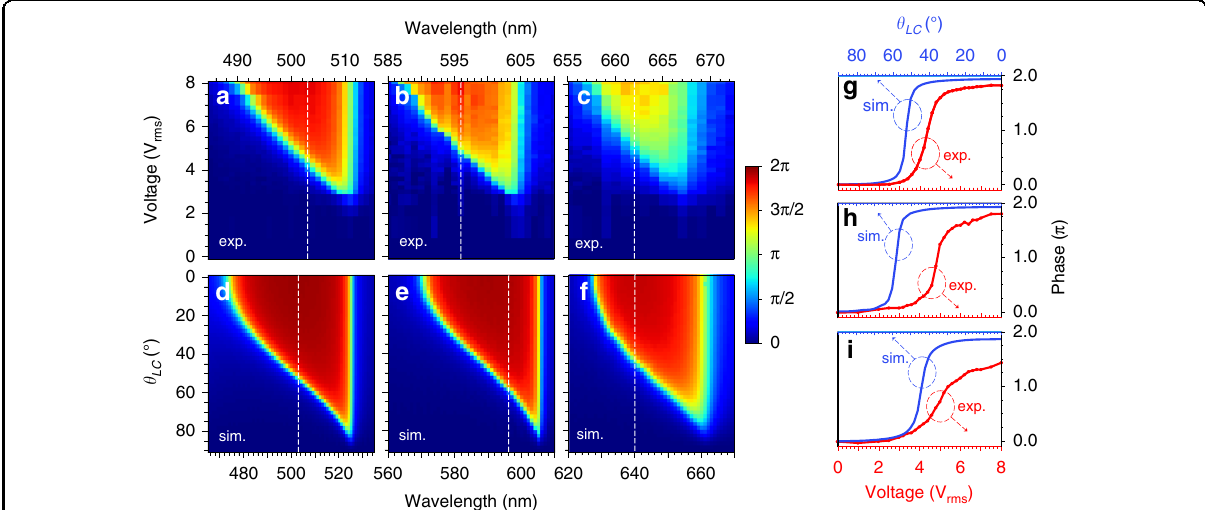
Fig. 3 Multi-spectral phase modulation of the FP-SLM. a – c Experimentally measured and ( d – f ) simulated phase shifts as a function of wavelength and, respectively, applied voltage to the FP-SLM device and LC director rotation angle ( θ LC ) around the operational wavelengths (shown as vertical dashed lines) in the blue ( a , d ) orange ( b , e ) and red ( c , f ) spectral regions. g – i Simulated (solid blue curve) and measured (solid red curve with symbols) at the operational wavelength in ( g ) the blue ( λ = 503 nm ), ( h ) the orange ( λ = 596 nm ) and ( i ) the red ( λ = 662 nm in simulation, λ = 640 nm in experiment) spectral